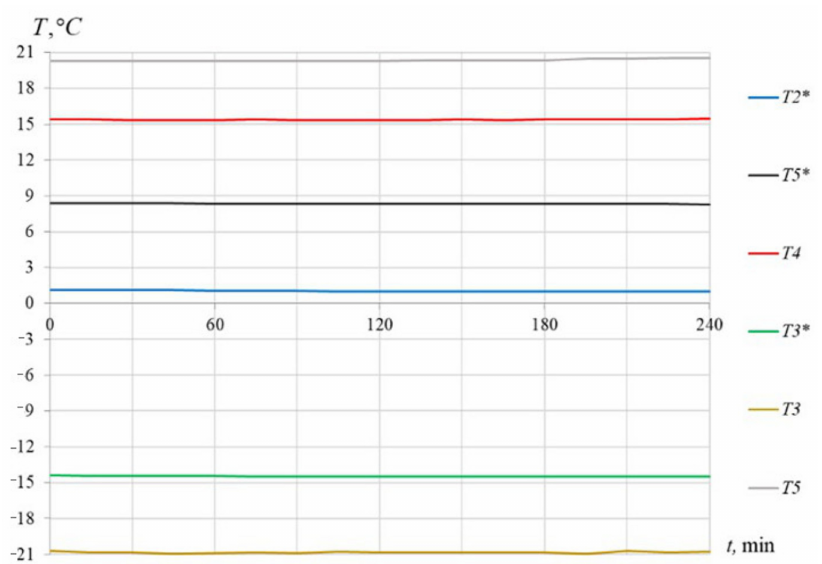
Figure 8. Steady state of